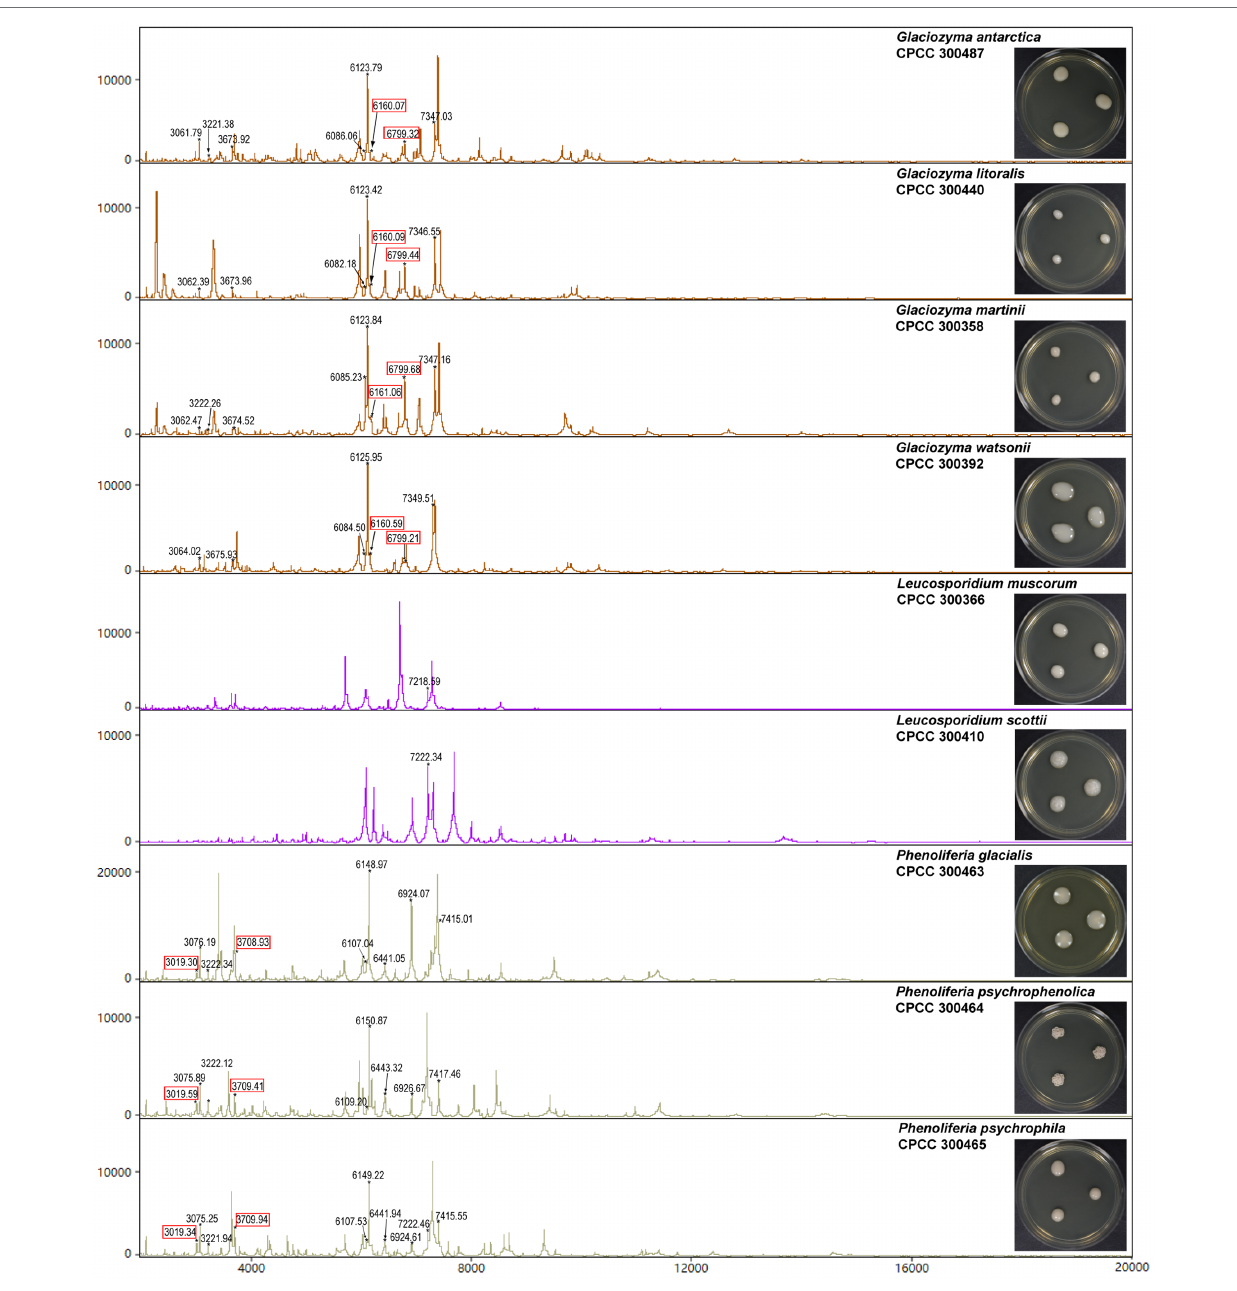
FIGURE 3 | Representative mass spectra of the nine yeast species in Microbotryomycetes. The Glaciozyma genus-specific markers (about m/z 6160 and 6799 Da) and Phenoliferia genus-specific markers (about m/z 3019 and 3709 Da) were indicated as the red